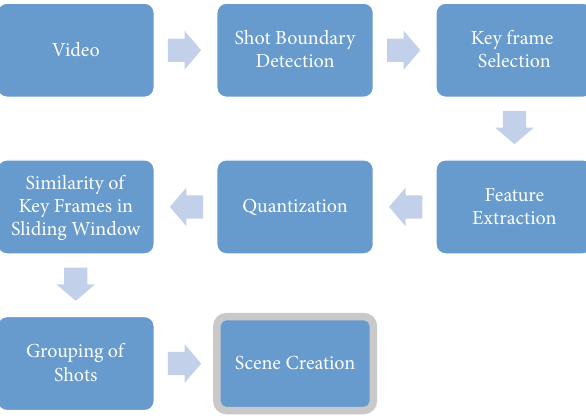
Figure 1: Abstract flow diagram of proposed